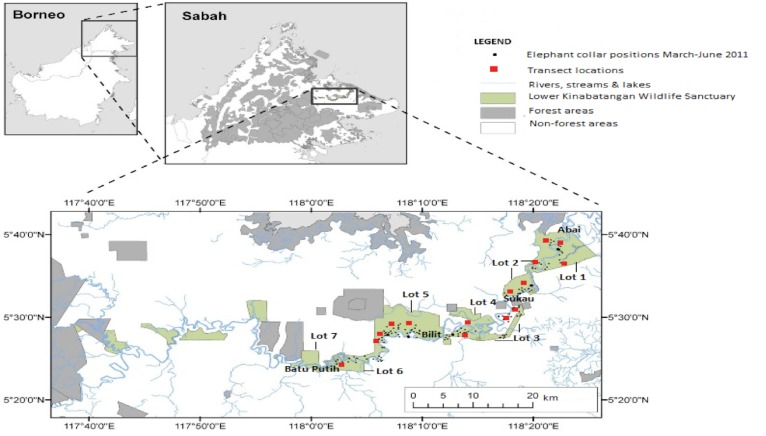
Map of study site.The Lower Kinabatangan Wildlife Sanctuary, Sabah, Malaysia (English et al., 2014b). Adapted from Clouded Leopard Project, Sabah www.cloudedleopard.org.